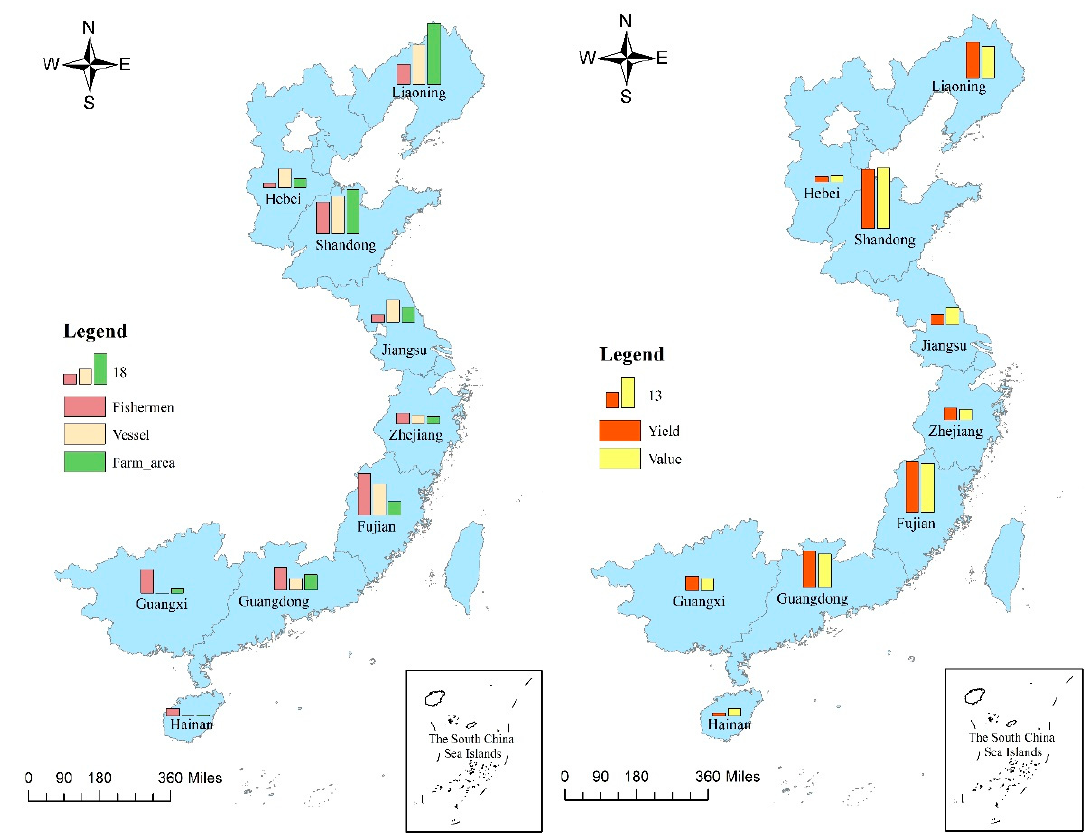
Figure 2. Input and output gaps in mariculture in China’s nine coastal provinces, 2016.